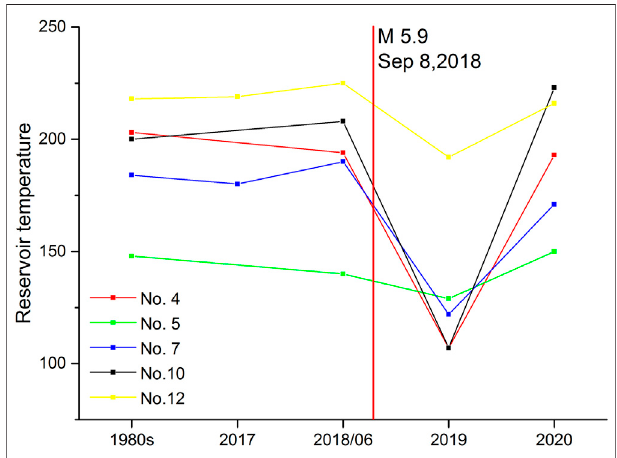
FIGURE 8 | Reservoir temperature variations in some springs from the 1980s to 2020.